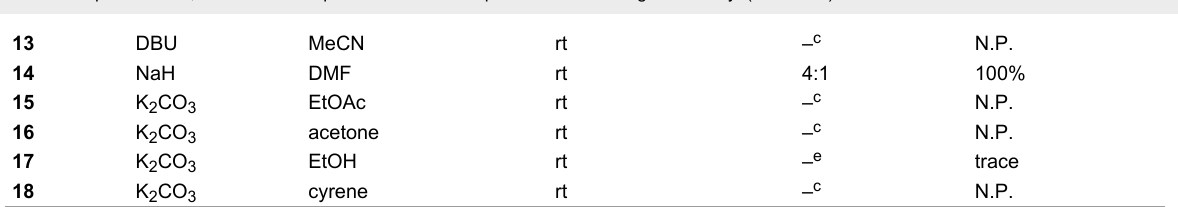
Table 2: Impact of base, solvent and temperature on reaction performance and regioselectivity.